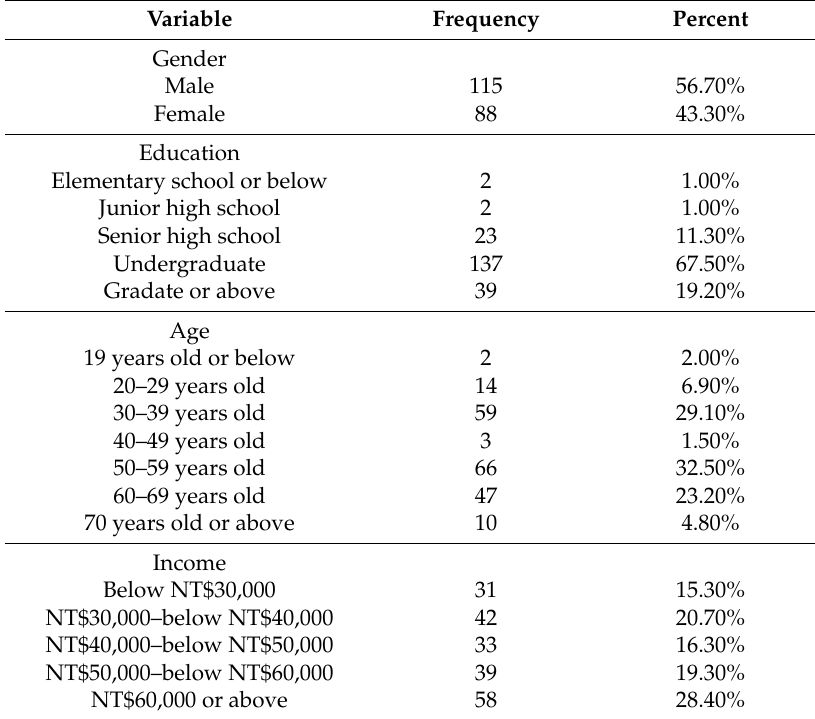
Table 1. Demographic profiles of respondents in Study 1 ( n =